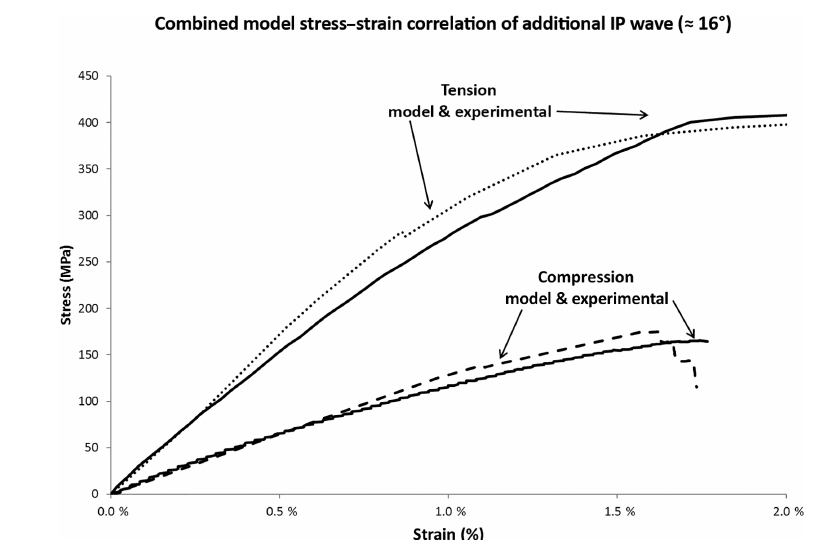
Figure 12. Resulting additional IP wave (16 ◦ ) stress–strain curves in tension and compression compared to experimental